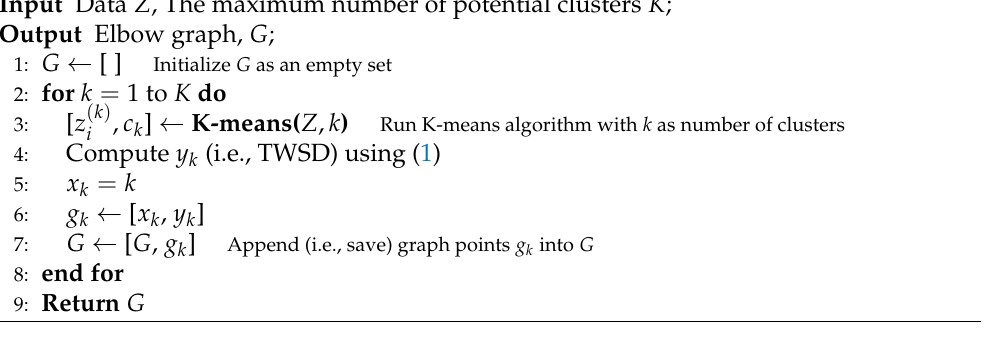
Algorithm 2 AutoElbow